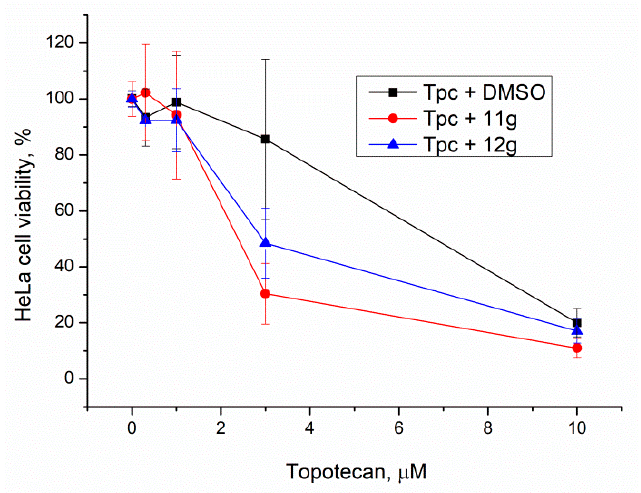
Figure 7. Influence of Tdp1 inhibitors at 20 µ M on topotecan cytotoxicity. Error bars show standard deviations.